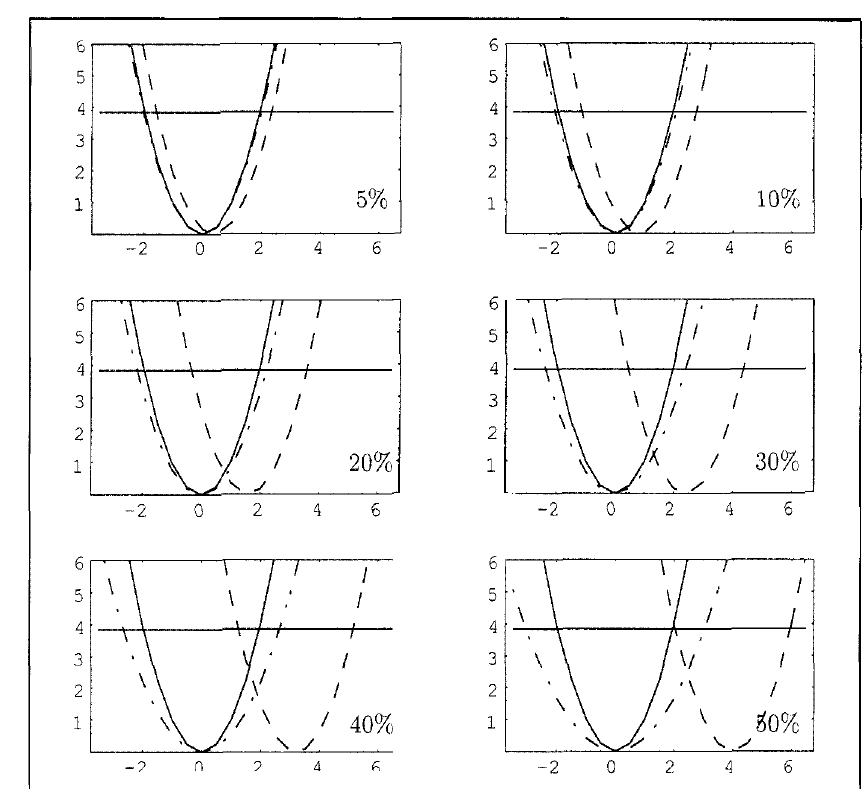
Fipm 1 - Valore asjntotico della funzione test di verosimiglianza (tratto a linea) e per il test di verosi- iniglimza pesata (tratto piinio e linea) per un modello di posizione normale e diversi valori di contami- nazione per f (x) = (1 - F) %:(0,1) + E $:(8,1). 1.a parabola a linea continua indica il valore asintotico del test di verosimiglianza per f(x) = %((),l) ed è riportata conle riferimento. La linea parallela all'asse delle ascisse corrisponde al valore del X: con Liri errore di primo tipo del 5%. dente alla densità normale con parametro di lisciamento v proporzionale al parame- tro di scala con k = 0.0034. I tre test di verosimiglianza pesata sono stati calcolati anche utilizzando un nucleo biweight nella forma k(x) = (15116) (1 - x2)' 1,-,,,,(x) e v = 2.3 on-'Ii = 202.16 dove MD/.6745 è usato come stimatore di scala (Nota che il parametro di lisciamento è scelto con il criterio L, di Devroye and Gyorfi, 1985). I1 nucleo hiweight e lo stesso parametro di lisciamento sono stati utilizzati da Simpson (1989) per calcolare il test basato sulla distanza di Hellinger. In tabella 2 sono invece presentate le stesse funzioni test calcolate sui dati privi della prima